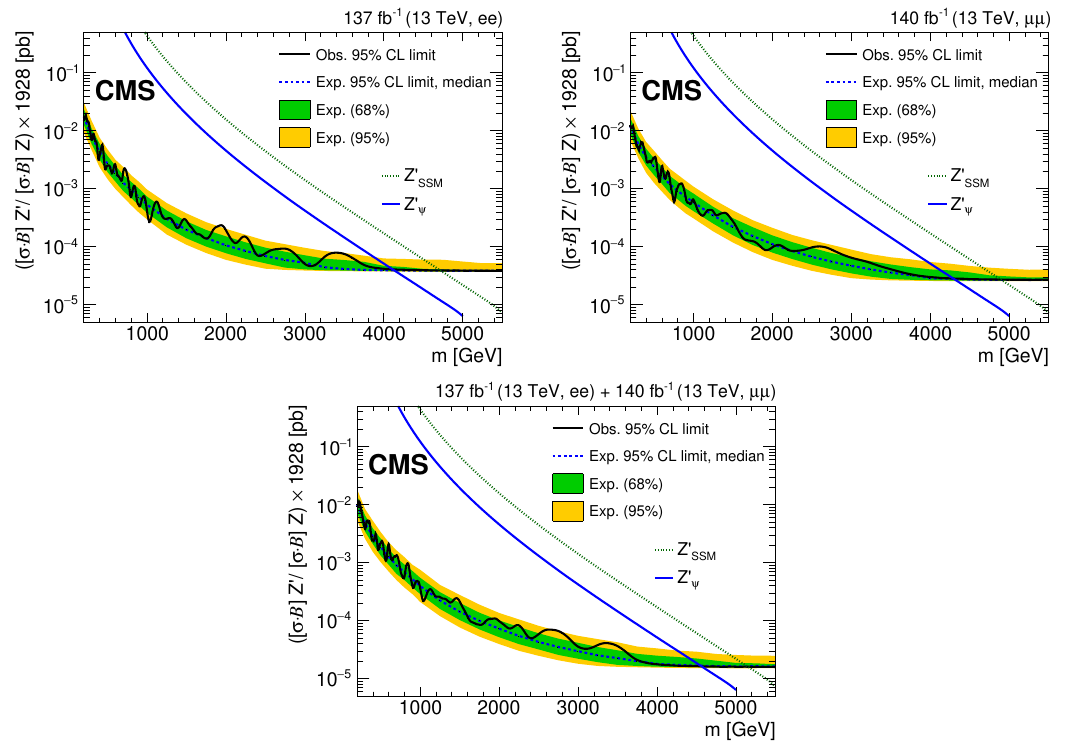
Figure 4 . The upper limits at 95% CL on the product of the production cross section and the branching fraction for a spin-1 resonance with a width equal to 0.6% of the resonance mass, relative to the product of the production cross section and the branching fraction of a Z boson, multiplied by the theoretical value of σ (pp → Z+ X → ‘‘ + X ) of 1928 pb, for (top left) the dielectron channel, (top right) the dimuon channel, and (bottom) their combination. The shaded bands correspond to the 68 and 95% quantiles for the expected limits. Simulated predictions for the spin-1 Z 0 Z 0 resonances are shown for comparison. ψ